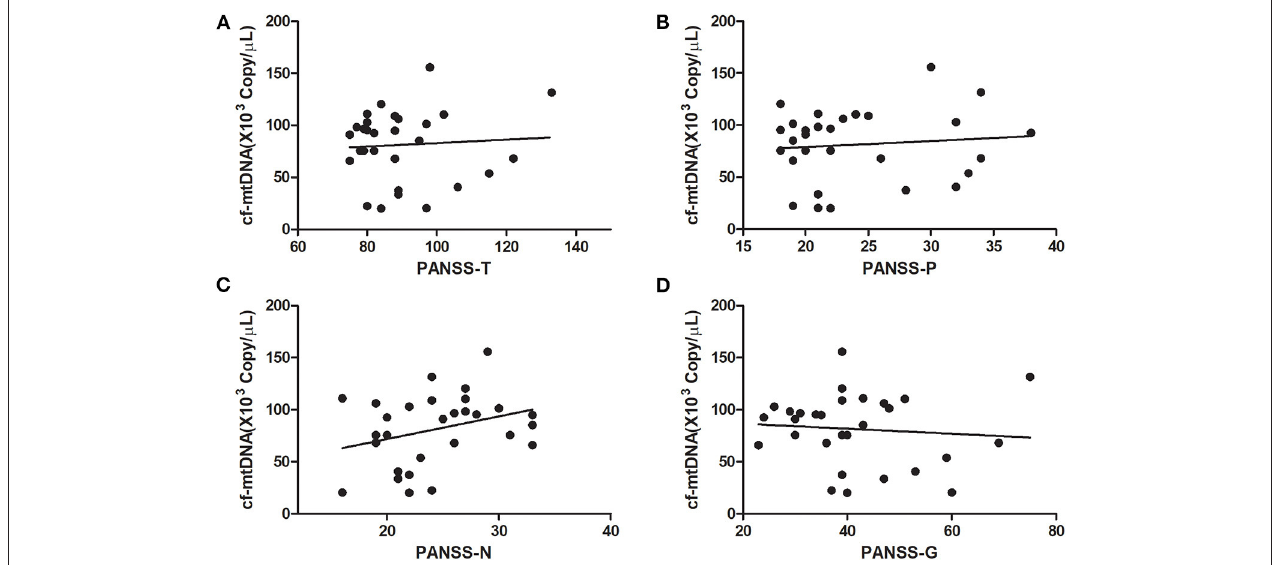
FIGURE 2 | Correlations between the cf-mtDNA copy number and components of the PANSS scores in first-episode patients with schizophrenia (in baseline). (A) r = 0.04, P = 0.83; (B) r = 0.23, P = 0.19; (C) r = 0.05, P = 0.77; (D) r = − 0.04, P = 0.84.